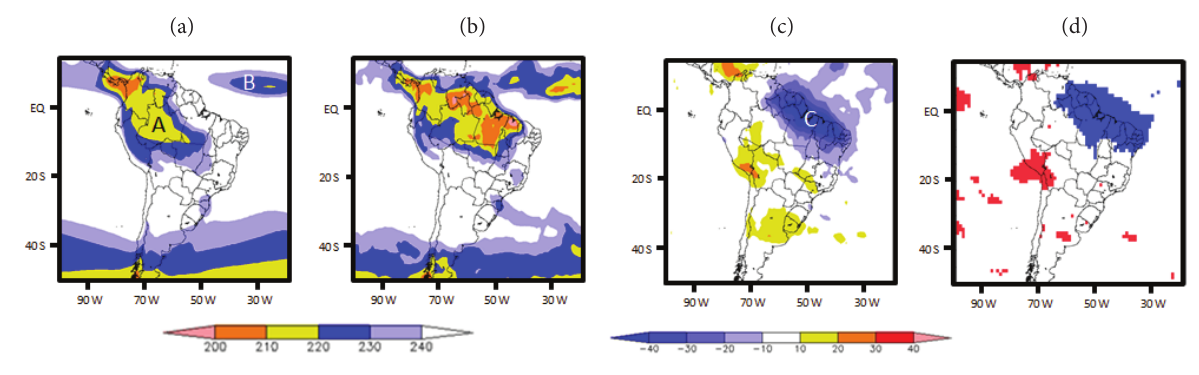
Figure 6. Mean OLR (W·m –2 ) (a) for the dry quarter (SON) in the period 1979-2012, (b) for the 15 days with heavy precipitation and deep convection, and (c) the difference between them, i.e., “b” minus “a”. (d) Differences are statistically significant at the 95% confidence level (Student’s t-test) over the shaded areas (blue: negative difference; red: positive). “A”, “B” and “C” refer to regions described in the text.